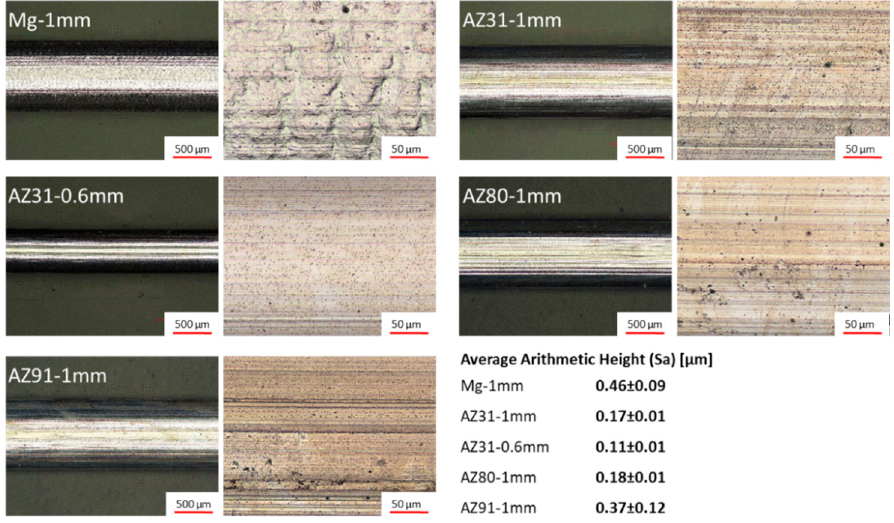
Figure 7. Surface characterization of the wires.